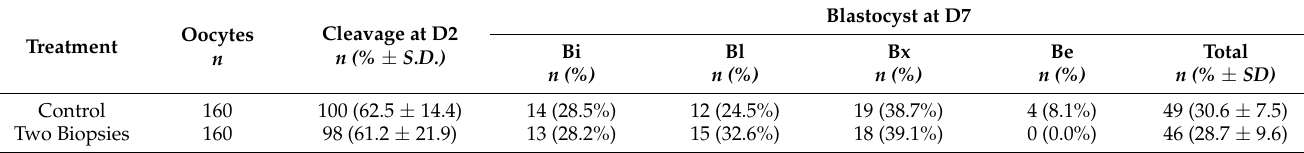
a,b Values with different superscripts in the same column are significantly different ( p < 0.05), according to Kruskal–Wallis test. Table 4. Number ( n ) and percentage ± standard deviation (% ± SD) of cleavage (D2) and embryo development (D7). Cumulus oocyte complexes (COCs) individually matured, fertilized, and cultured were submitted or not (Control) to a biopsy before and after in vitro maturation (Two biopsies). Cleavage at D2 Oocytes Treatment n (% ± n